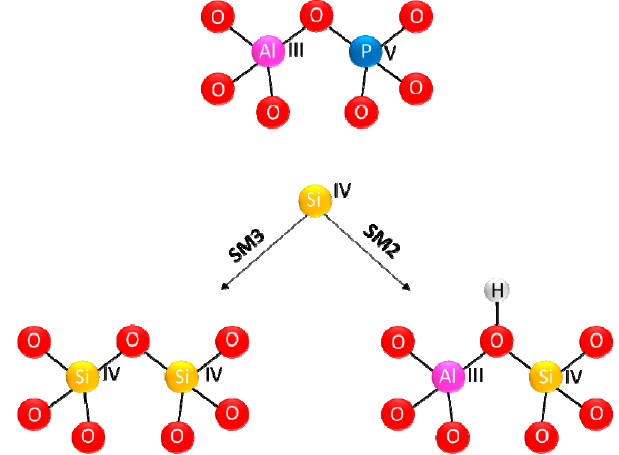
Figure 2. Scheme of the SM2 and SM3 mechanisms for Si substitution into the SAPO-34 framework. O is presented in red, Al in purple, Si in yellow, and P in blue.